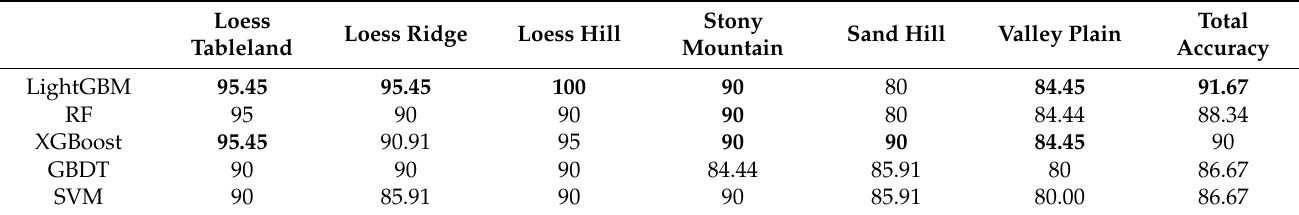
Table 6. Comparisons between the five kinds of machine learning methods. The bold number represents the greatest values in each column.